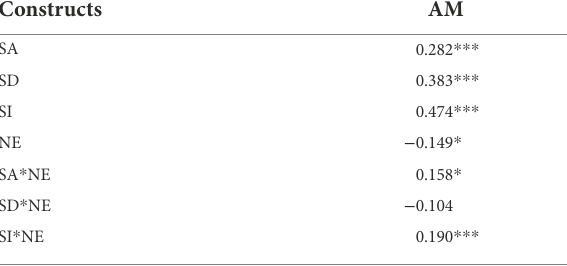
TABLE 7 Moderating effect testing result.